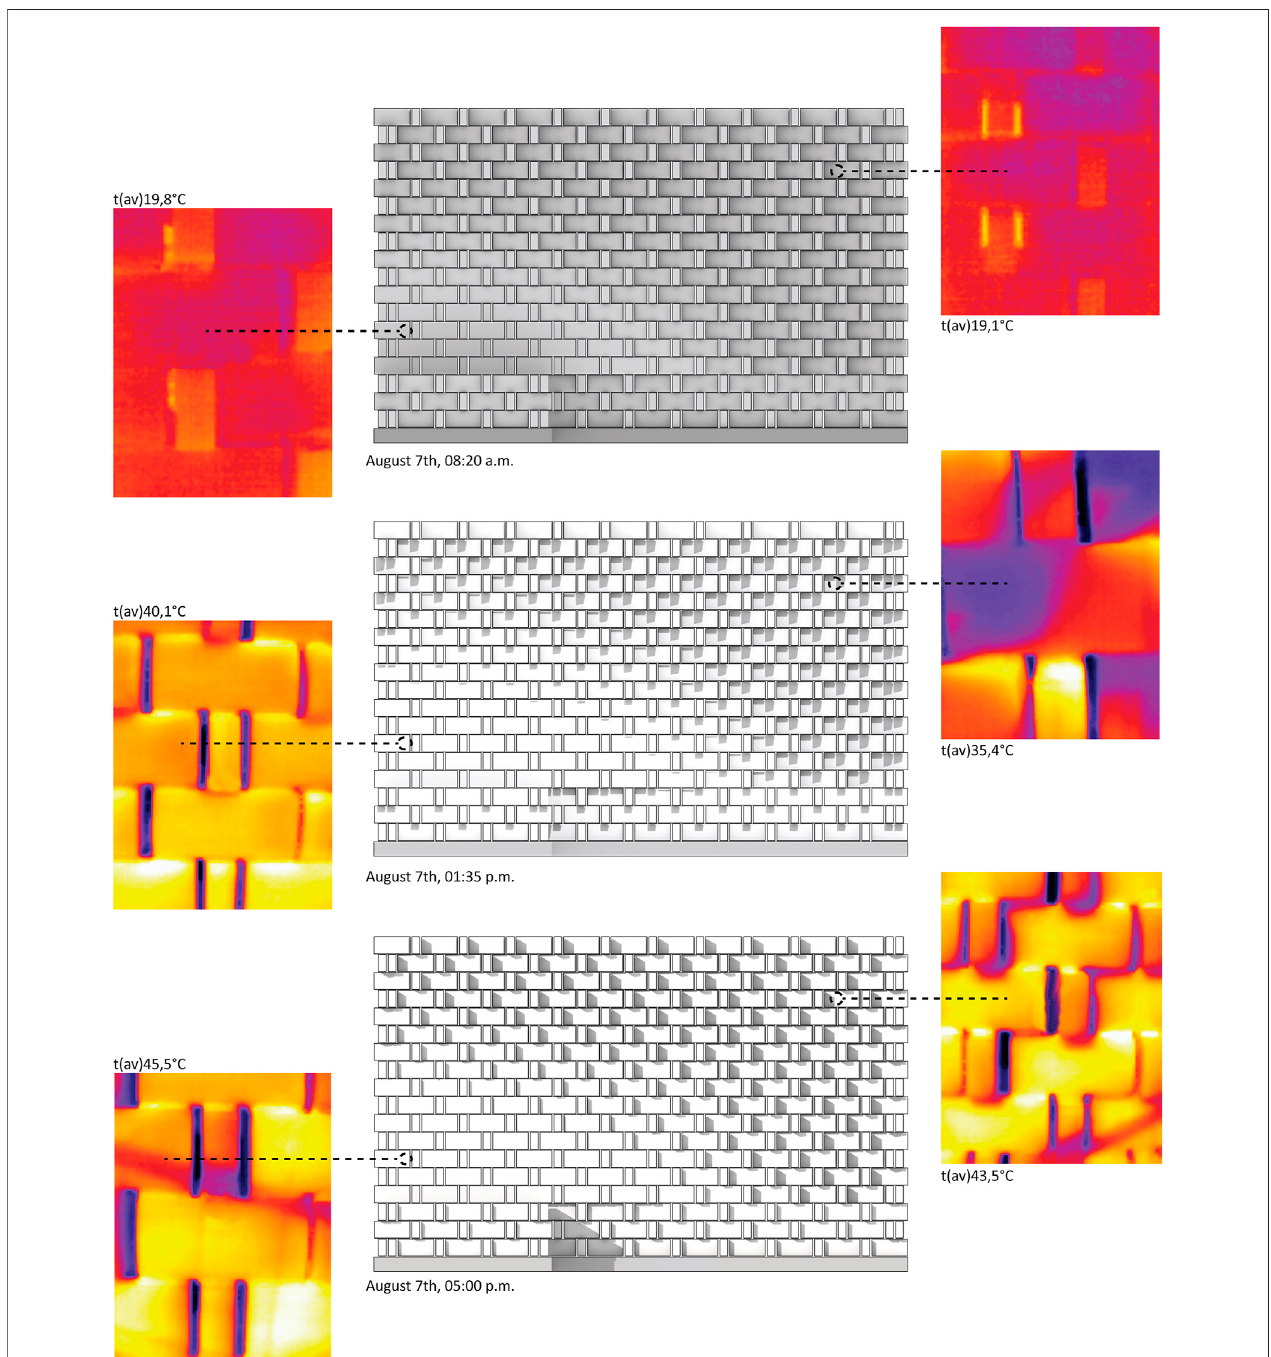
FIGURE 12 | Images of the thermal camera at three different times during a hot sunny day (seventh of August) in Munich.